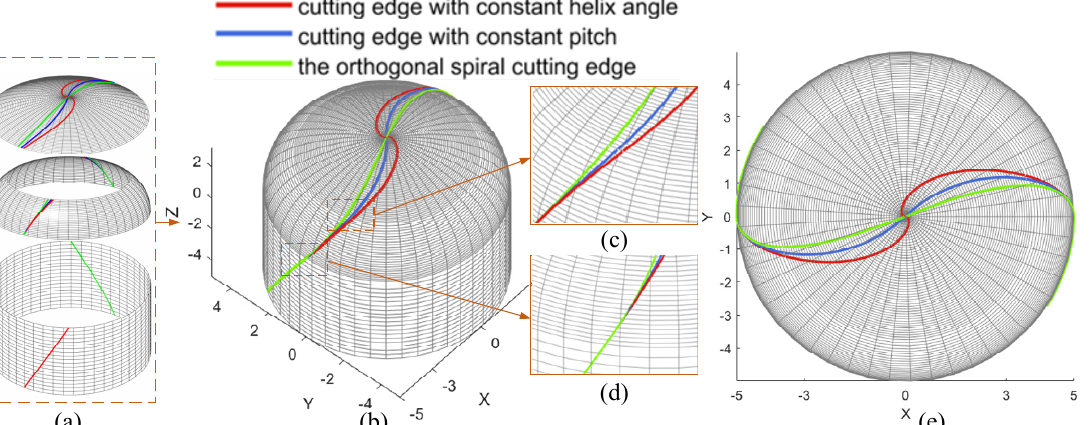
Figure 11. Simulation of three types of cutting edge curves of DACT: ( a ) three parts of DACT; ( b ) three types of cutting edge curves of DACT; ( c ) enlarged view of the transition area between the cutting edge of the bottom part and the ring torus part; ( d ) enlarged view of the transition area between the cutting edge of the ring torus part and the cylindrical part; ( e ) top view of cutting edge curves.